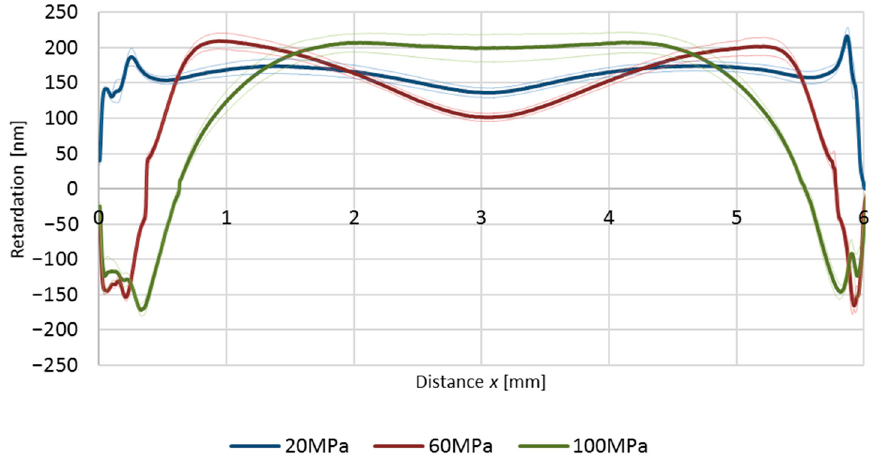
Figure 9. Calculated retardation of light passing through samples prepared at different holding pressures ( P h ). Thin lines represent standard deviation.